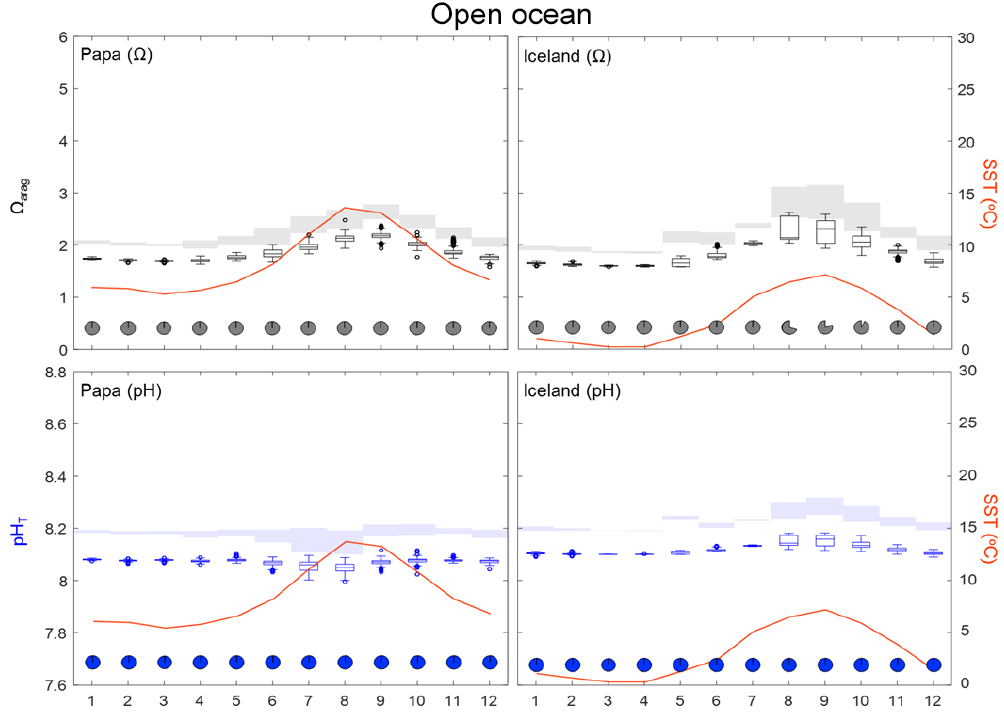
Figure 4. Box and whisker plots of present-day monthly surface seawater (cid:127) arag (top) and pH (bottom) and monthly mean SST at the open ocean mooring locations in subarctic regions with pronounced seasonality of physical and biological conditions (Papa, Iceland). See detailed description of figure components in Fig. 2